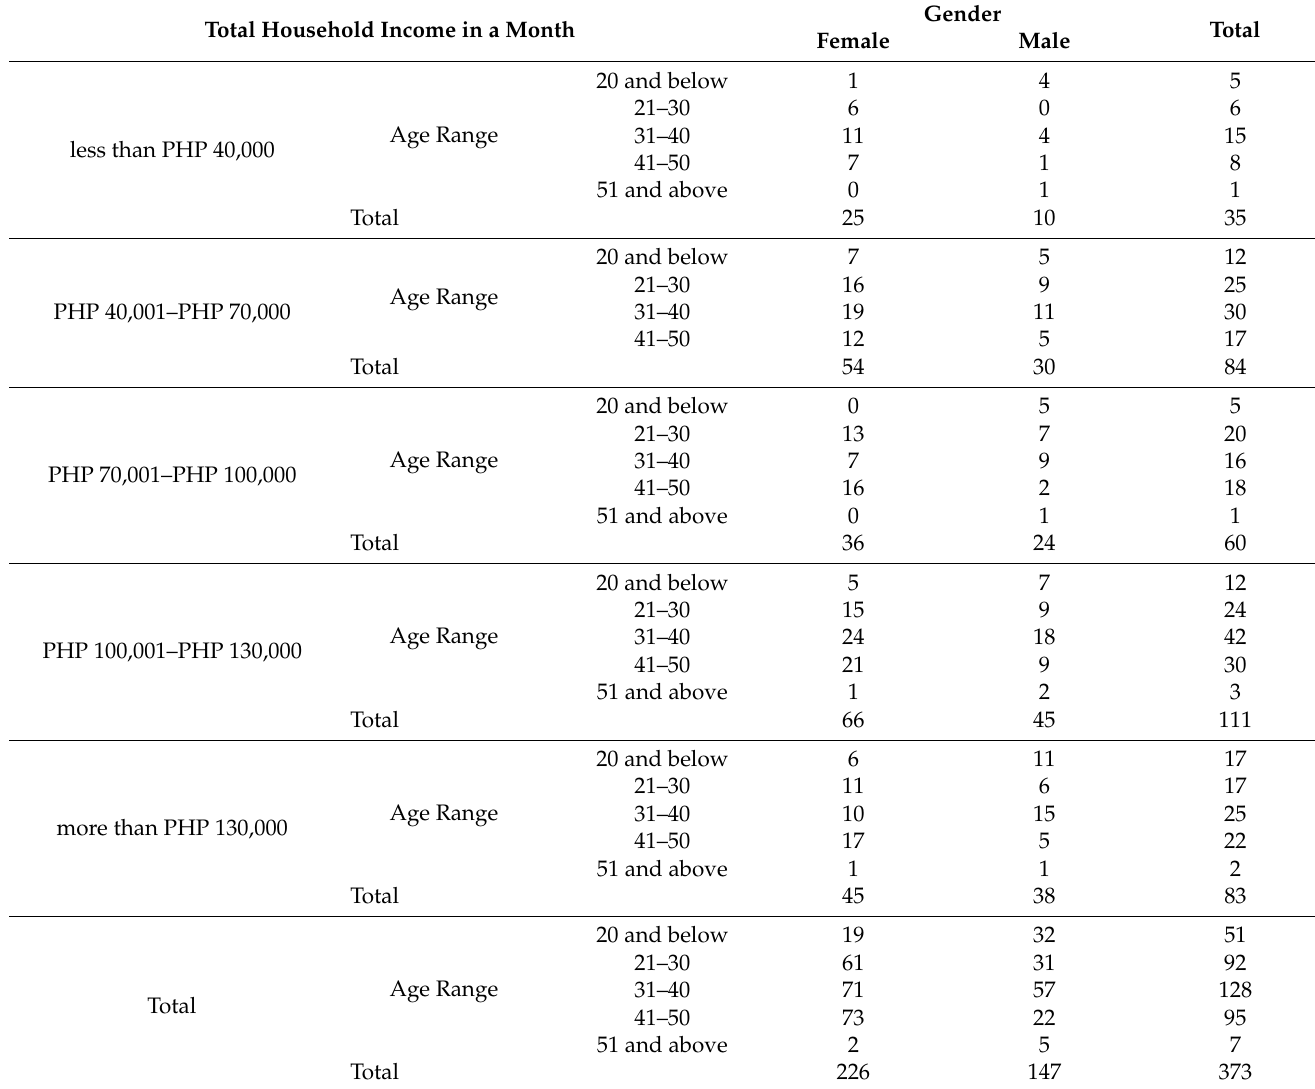
Table 3. The cross tabulation of age vs. gender vs. monthly